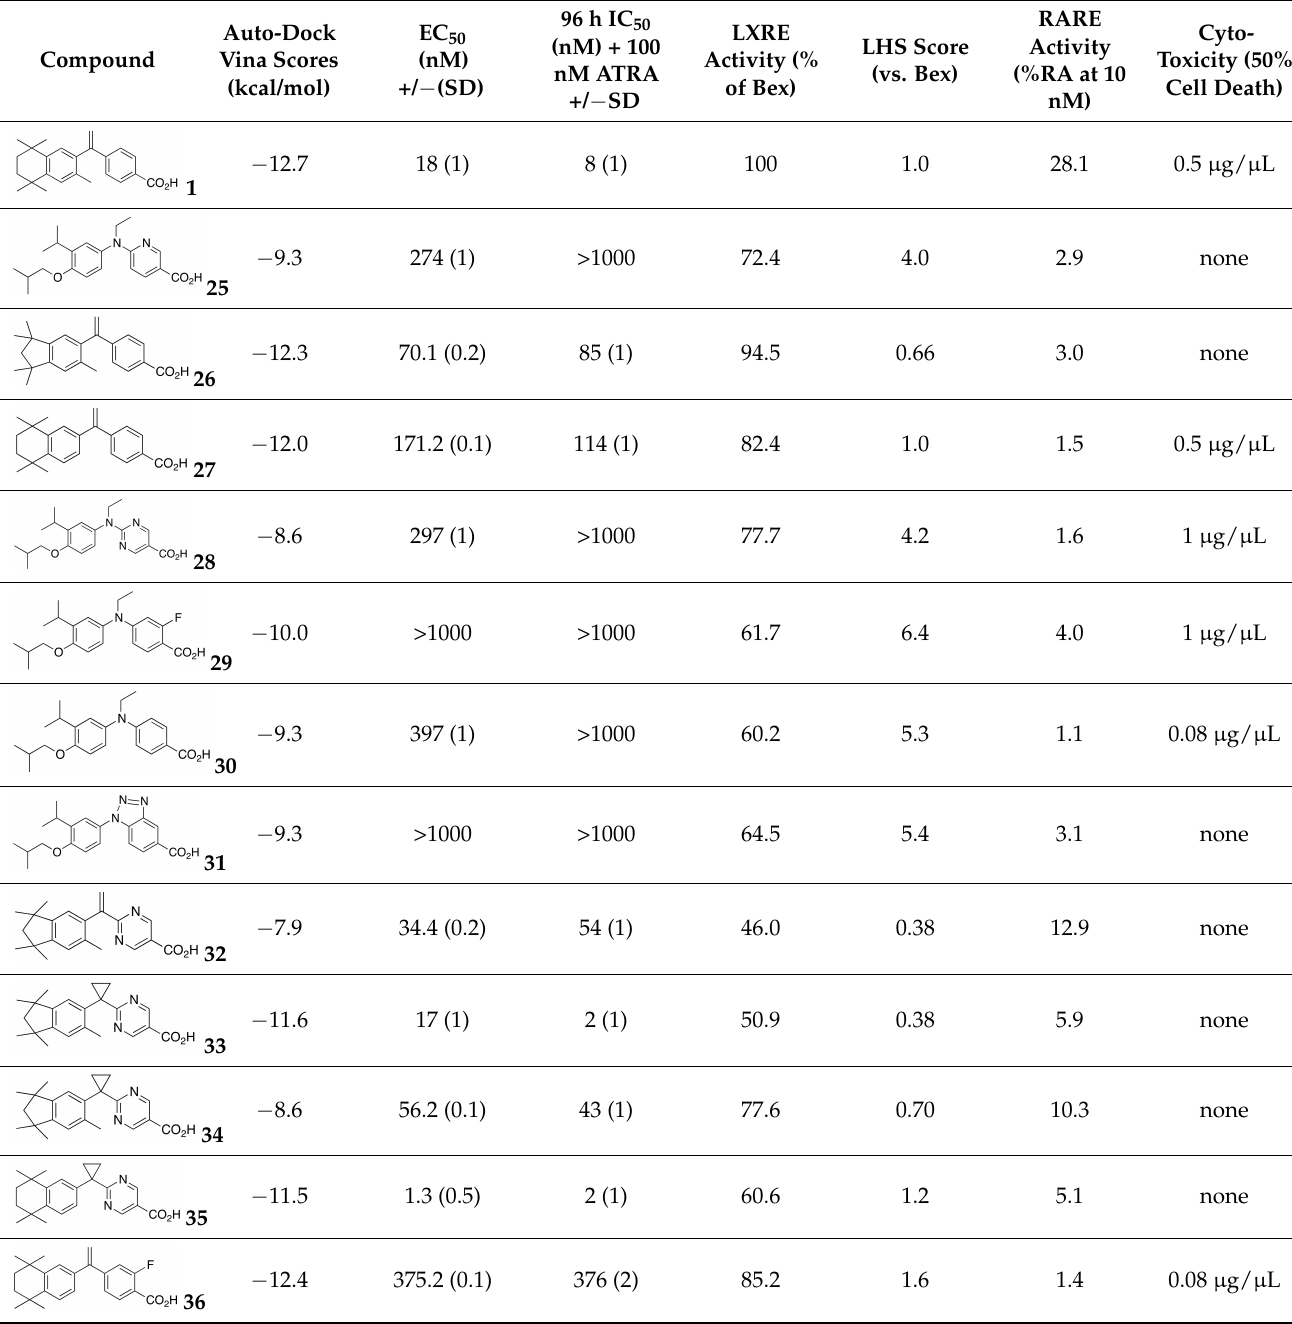
Table 1. Auto-Dock Vina scores, EC 50 values, IC 50 values, LXRE activities, LHS scores, RARE activities, and cytotoxicities for Bex and compounds 25–36, 37a, and 37b.